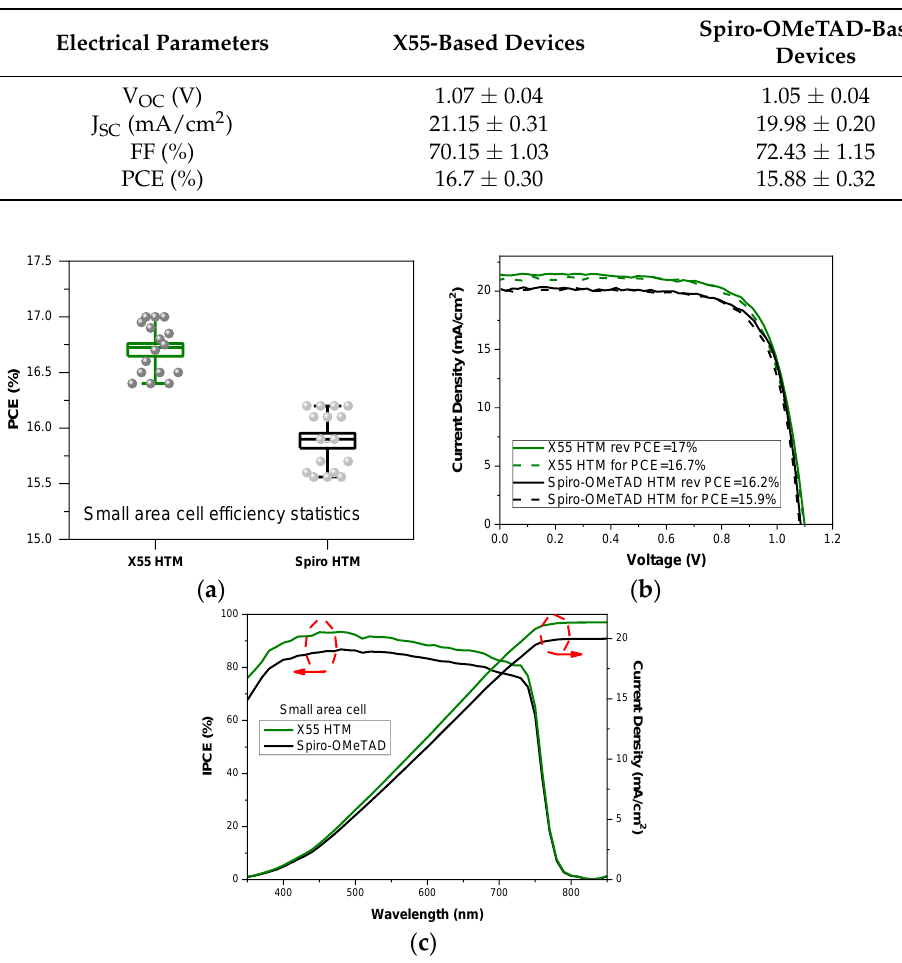
Figure 2. ( a ) Efficiency statistics of the fabricated small area cells (0.09 cm 2 ). ( b ) JV curves of the best small area cells and ( c ) corresponding incident photon to current efficiency